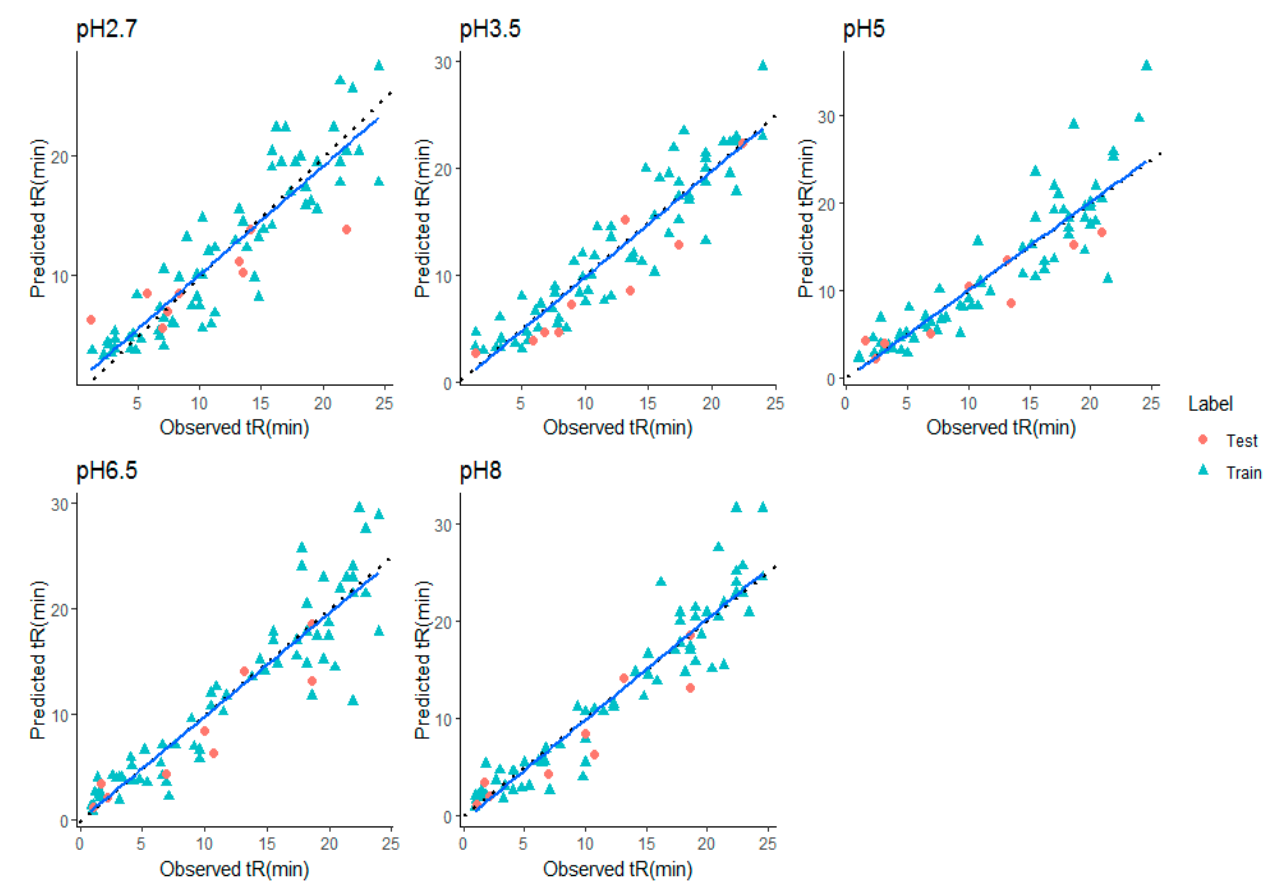
Figure 4. Predicted vs. experimental retention times (in min.) for stacking model at all pHs (after removing Miconazole). (Blue line—Fit, Black dashed line—identity line). Table 6. Applicability domain calculated for each compound in test set. (Errors in columns 2,3,4,5,6 are the errors of prediction from all the models specific for compounds. Distances in columns 5,6,7,8,9 are their distances calculated using KNN fixed methods). Errors are based on back-trans- formed retention times (min unit).